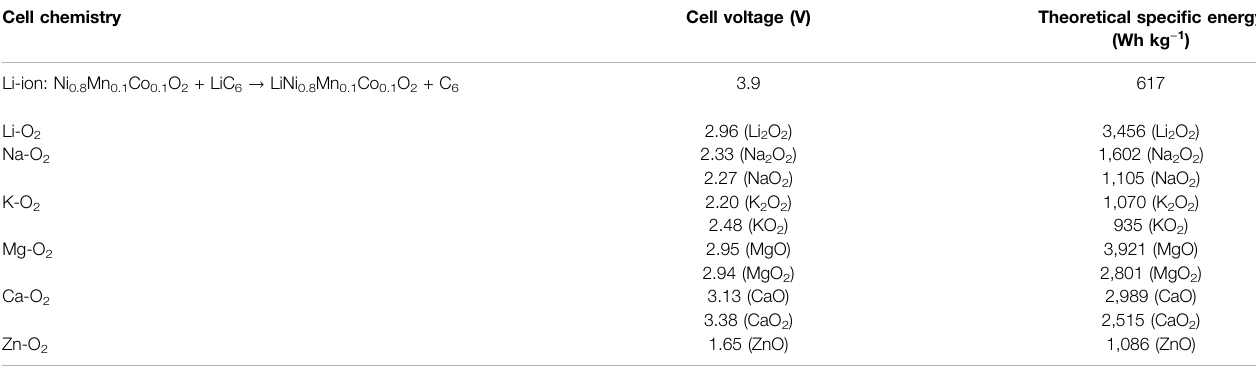
Chemical formula of primary discharge product shown in brackets.